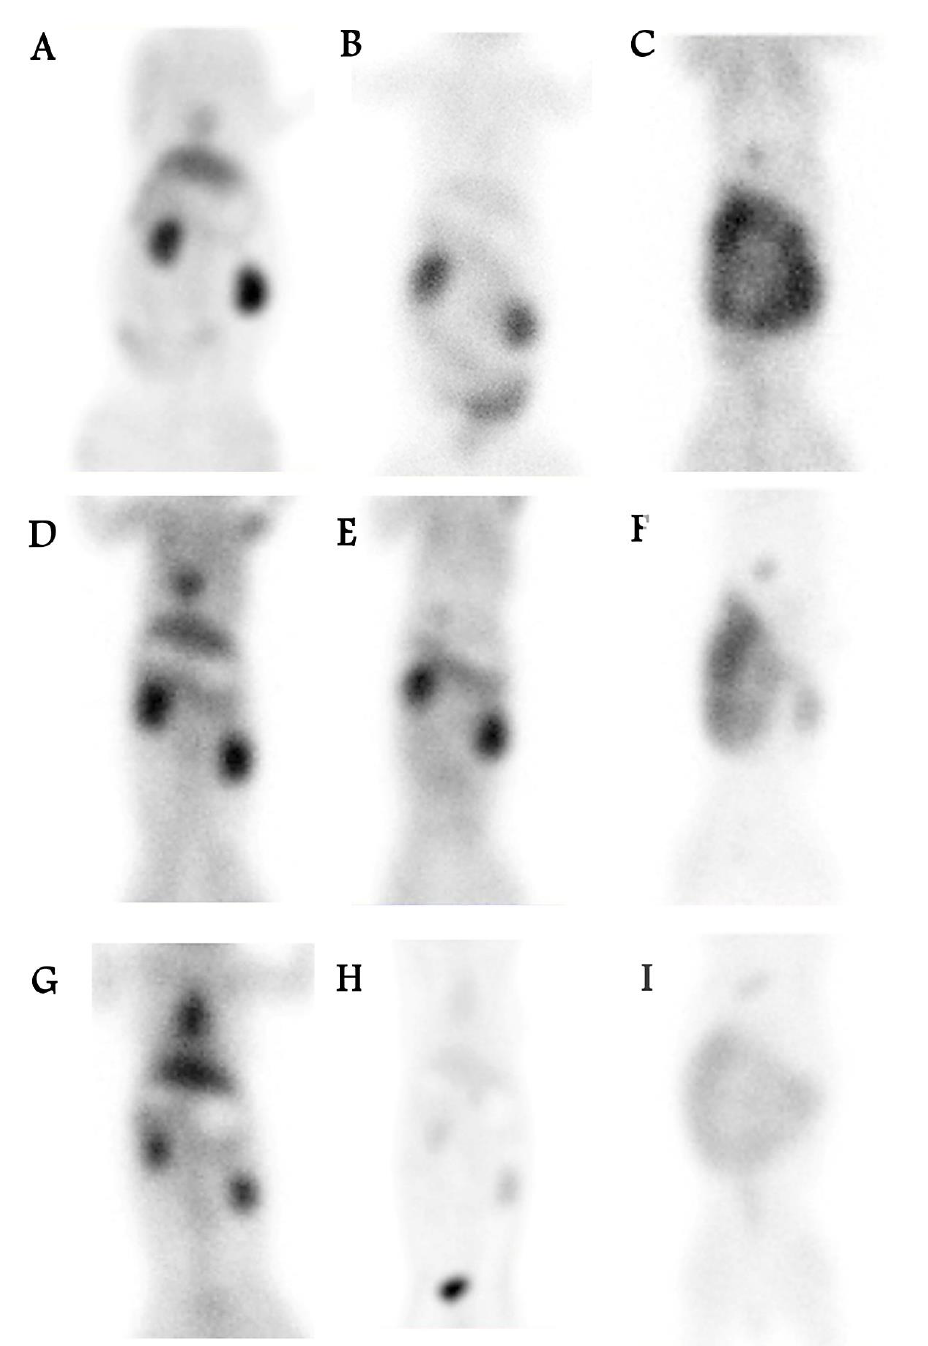
Figure 4. Anterior whole-body images of rabbits acquired using a dual-head gamma